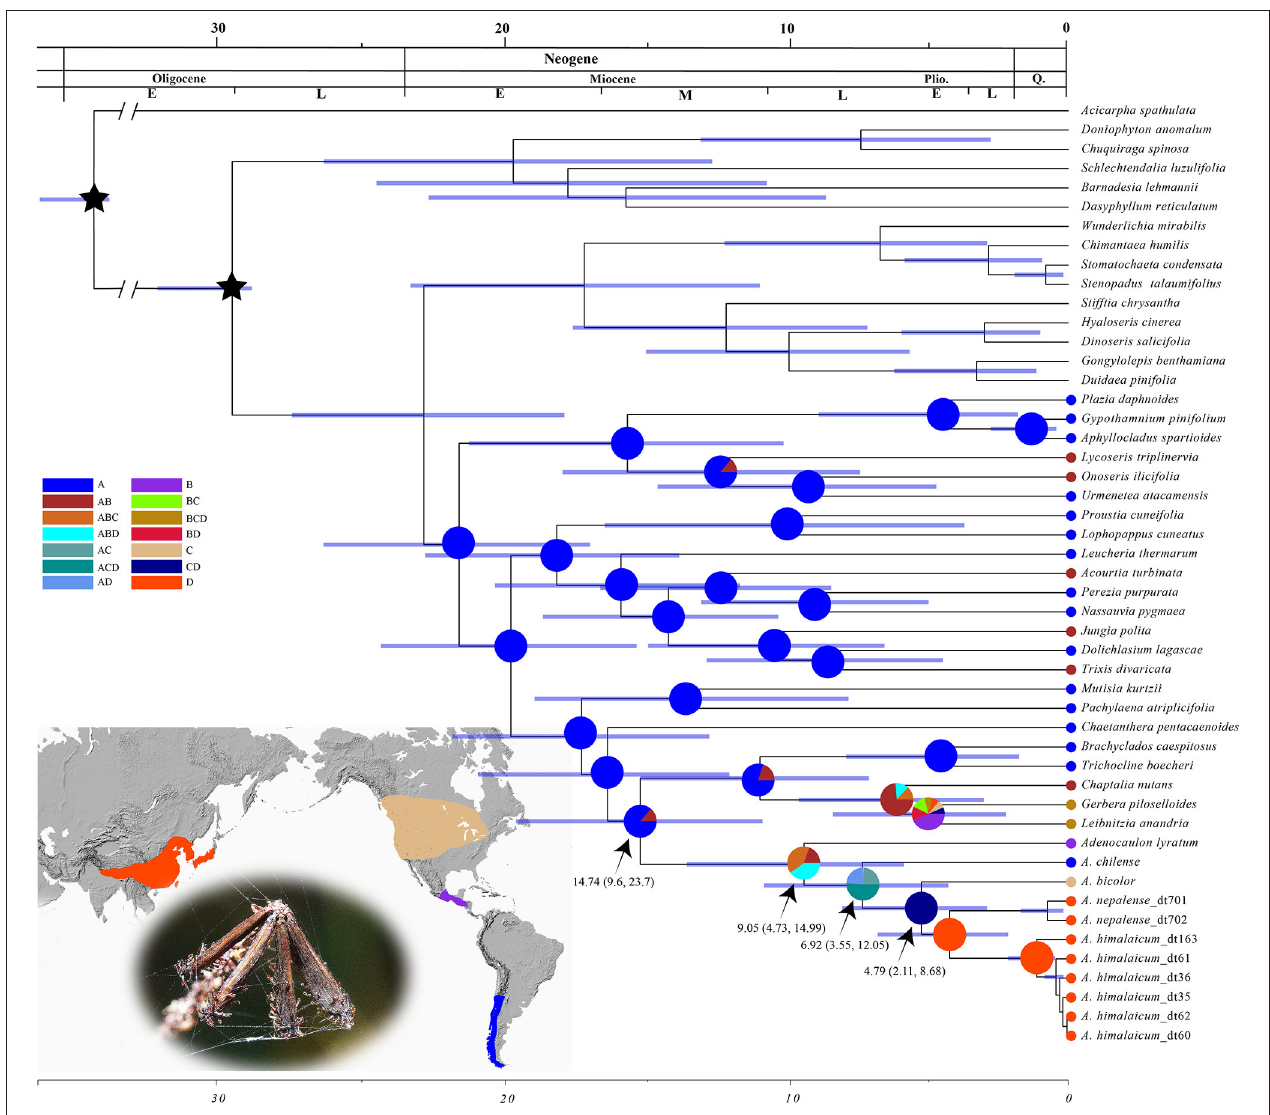
FIGURE 3 | The results of BEAST analysis and RASP ancestral area reconstruction analysis based on combined chloroplast DNA and nrITS. Blue bars represent the 95% highest posterior density intervals for node ages. Fossil calibrations are marked with black stars. Four areas of endemism are defined: A (blue), South America; B (purple), Central America; C (yellow), North America; D (red), eastern Asia. Pie charts show probabilities of ancestral area